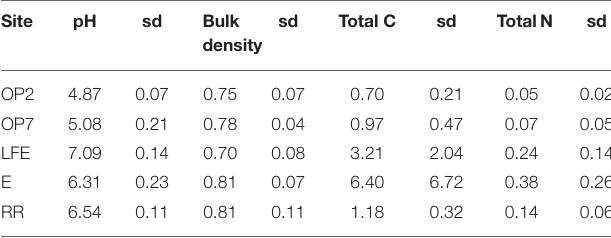
TABLE 1 | Soil properties from soil taken from the top 10cm including mean pH, bulk density (g cm − 3 ), total Carbon (C) and total Nitrogen (N) in %, sd is standard deviation of n =